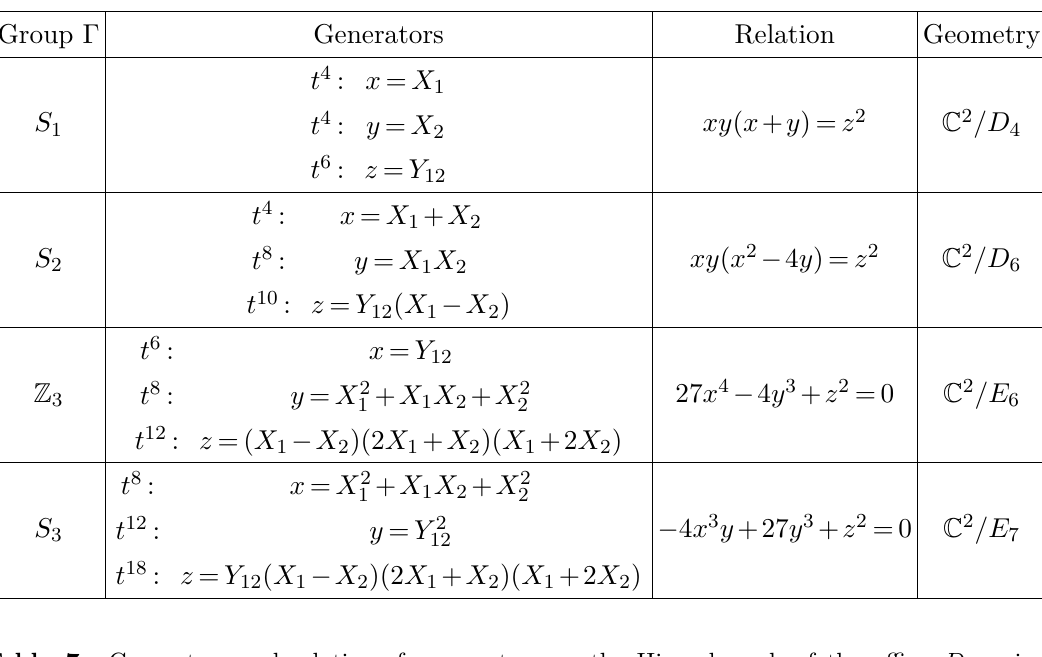
Table 7 . Generators and relations for operators on the Higgs branch of the affine D 4 quiver wreathed by subgroups of S 3 .